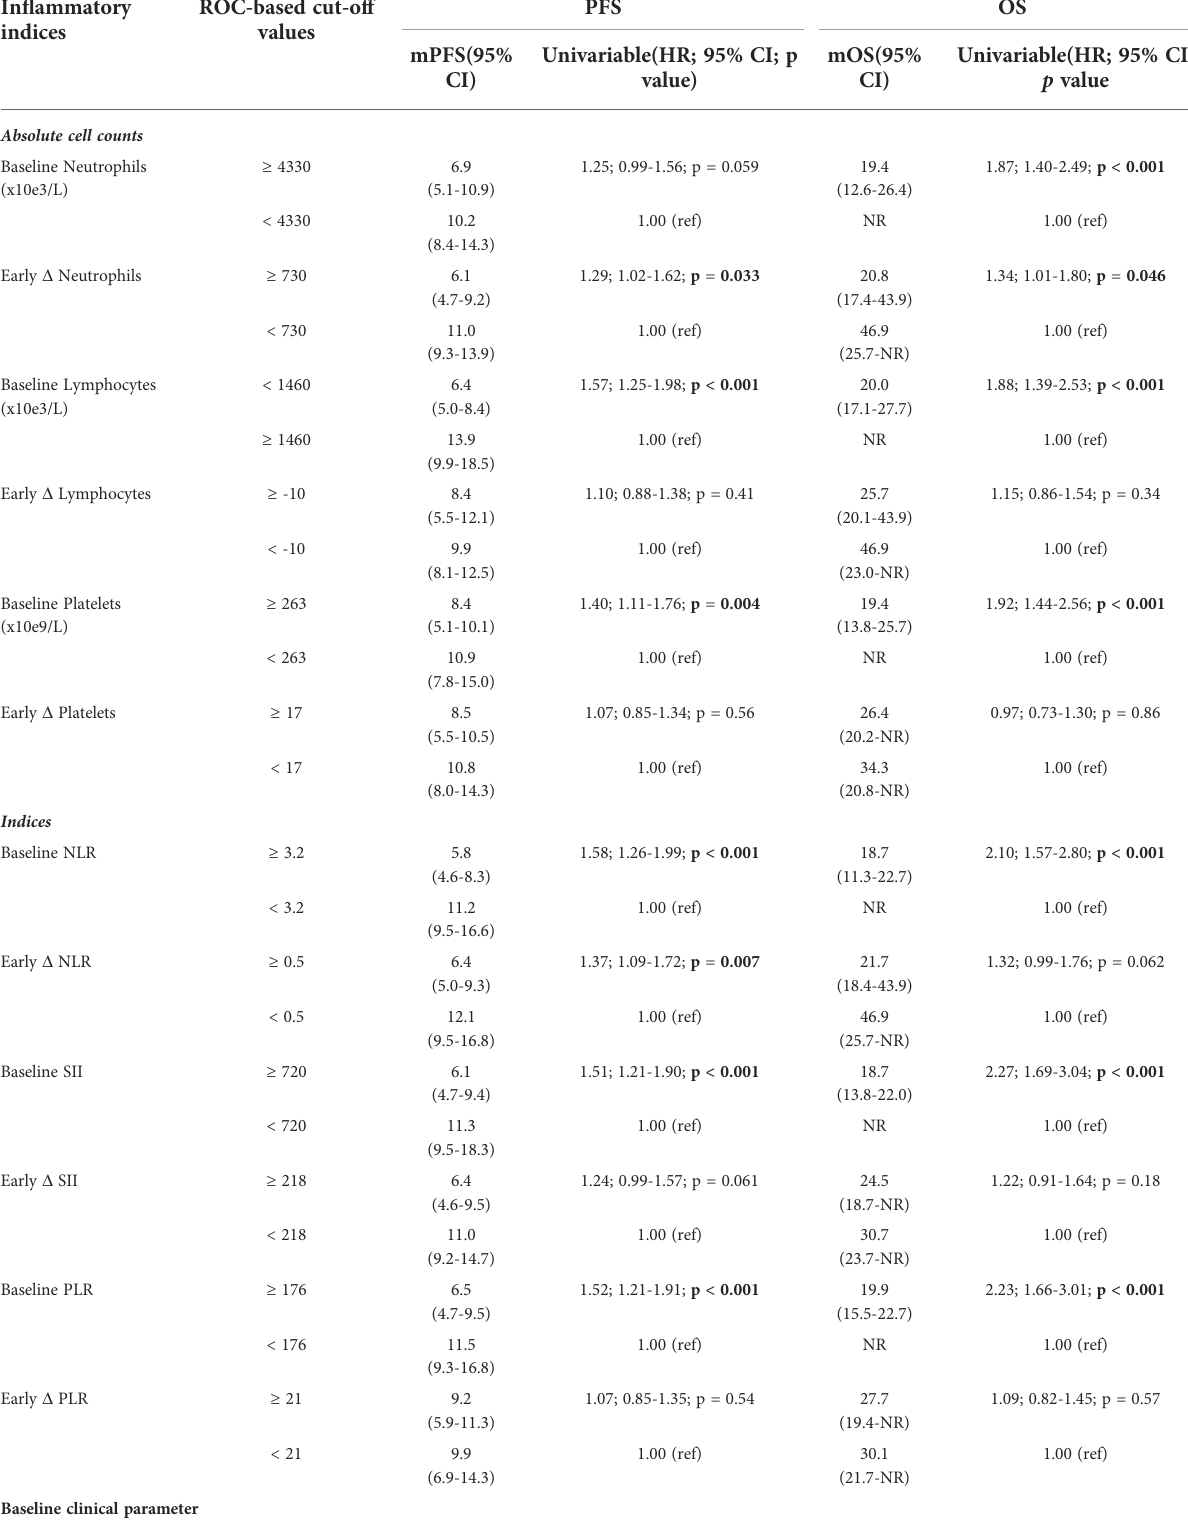
TABLE 2 Univariable analysis on survival outcomes of absolute cell counts and immune-in fl ammatory indices baseline and early D , and baseline clinical parameters. In fl